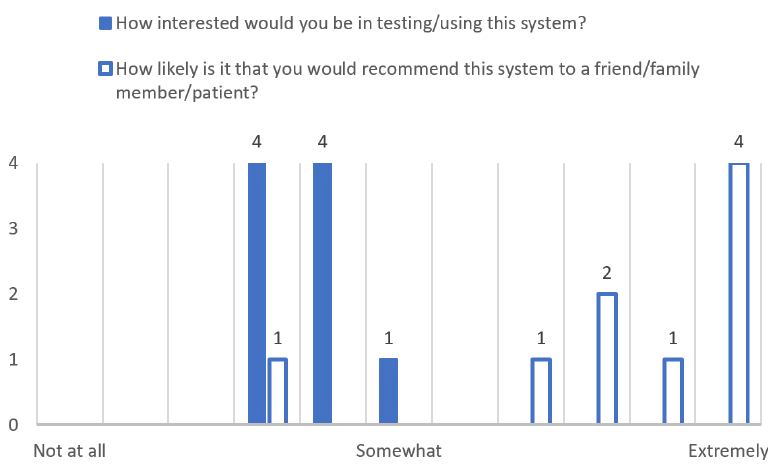
Figure 5. Likelihood to use the system or recommend the system.